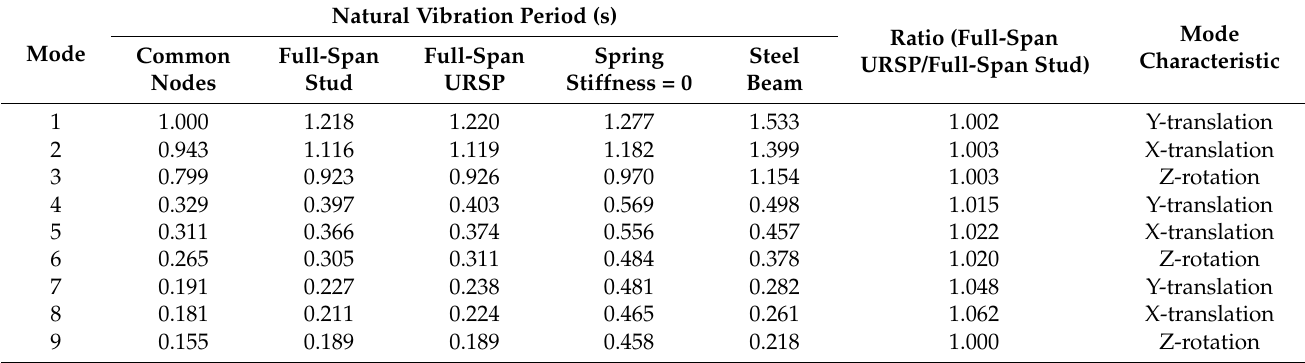
Table 1. Natural vibration characteristics with various interface